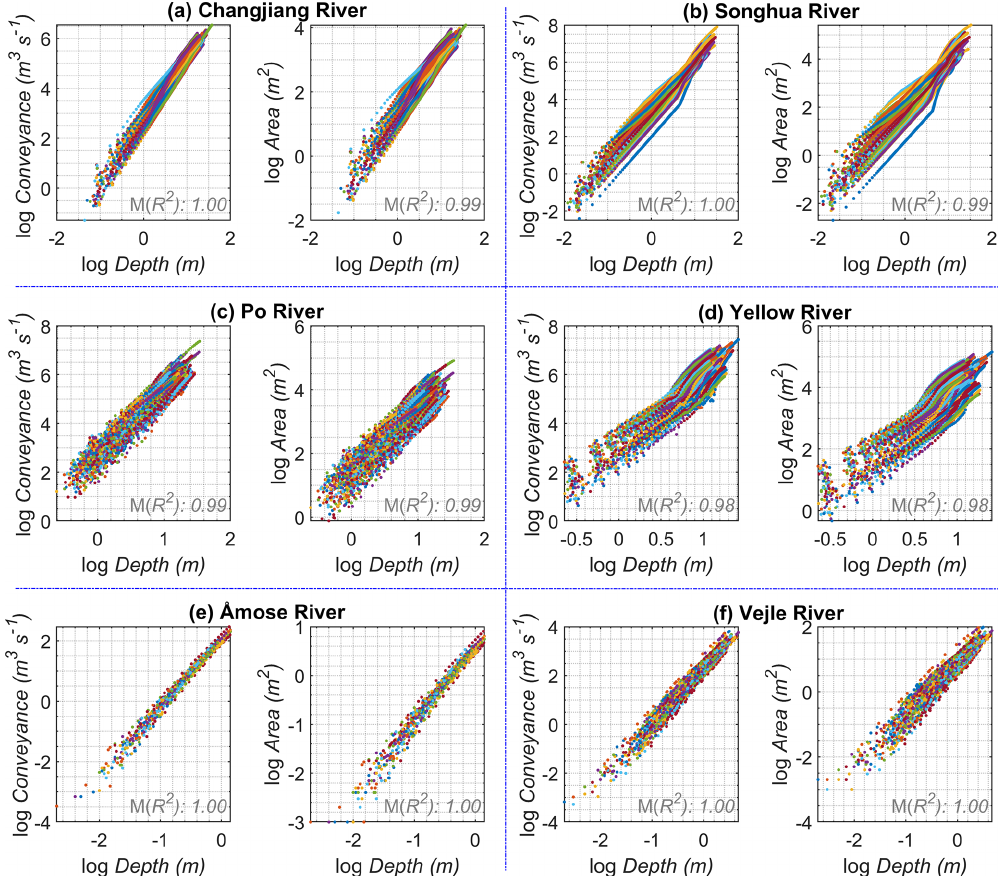
Figure A2. Relationship between logarithmic depth and logarithmic area and logarithmic conveyance. Similar to Fig. 1 but a uniform Manning’s coefficient of 0.03 was used to calculate conveyance. This results in a stronger linear relationship. However, a uniform Manning’s coefficient is not very realistic in natural